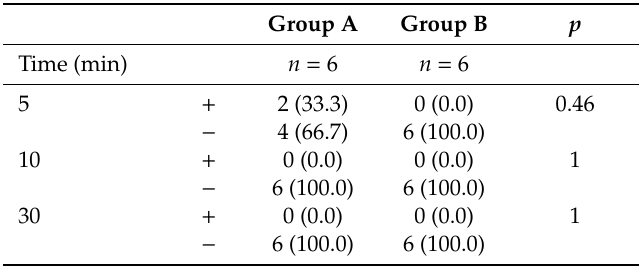
Figure 2. Leakage (arrow) observed by video-assisted ( A ) thoracoscopy and ( B ) lymphangiography immediately after thoracic duct injury by electrocautery, and the leakage was healed at ( C , D ) 5, ( E , F ) 10, and ( G , H ) 30 min as shown in the surgical field and lymphangiography images. (Group B #4 pig). Table 2. Statistical analysis between groups A and